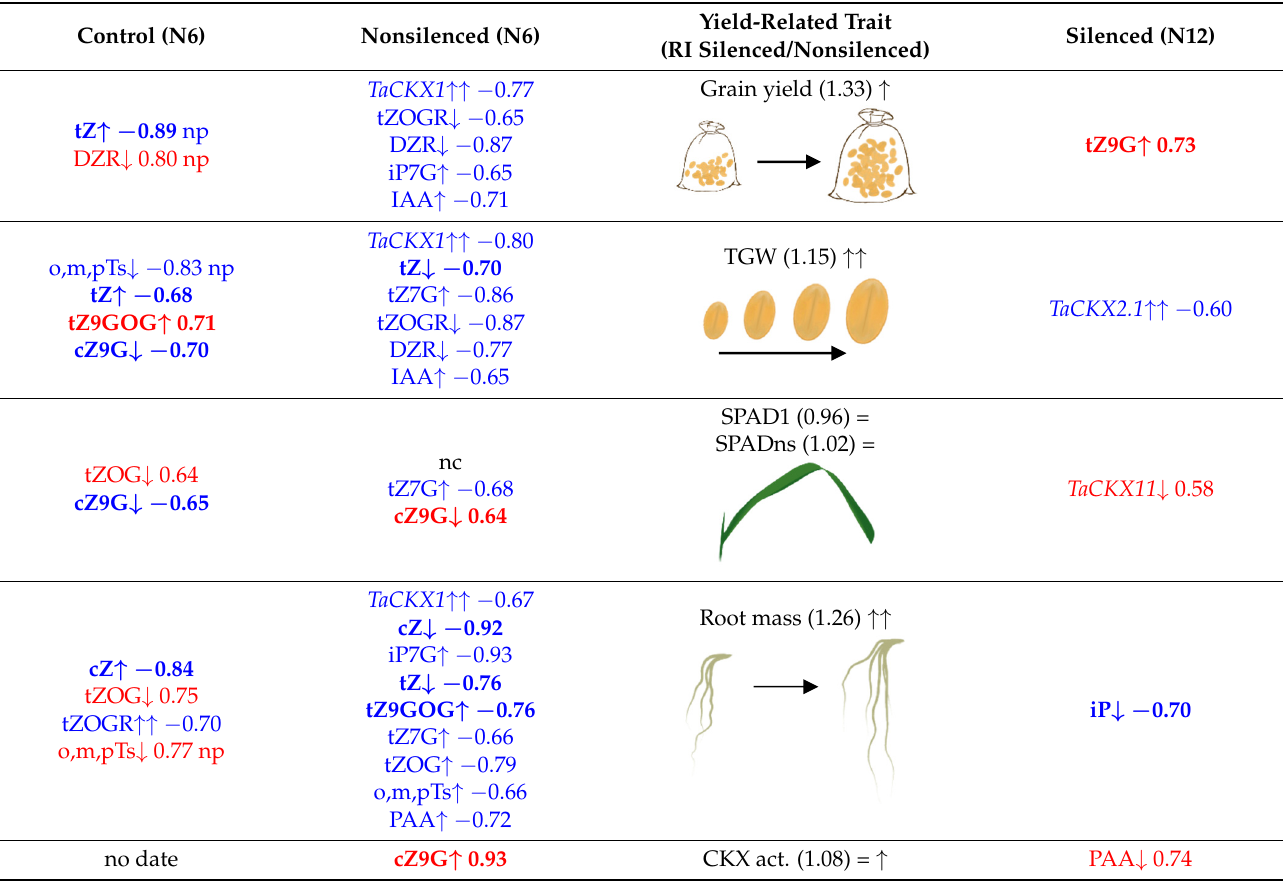
Positive (red) and negative (blue) correlation; nc—not correlated; bold—degraded by CKX; (…) ratio indicator; for N12 significant from 0.58 and for N6 significant from 0.81, (N—number of objects/tested lines); ↑ , ↓ —increase or decrease; ↑↑ , ↓↓ —significant increase or significant decrease; np—nonparametric analysis. Table 2. Regulation of yield-related traits by TaCKX GFMs and phytohormones in groups of silenced TaCKX2.2.1 , nonsilenced and control plants based on correlation coefficients.